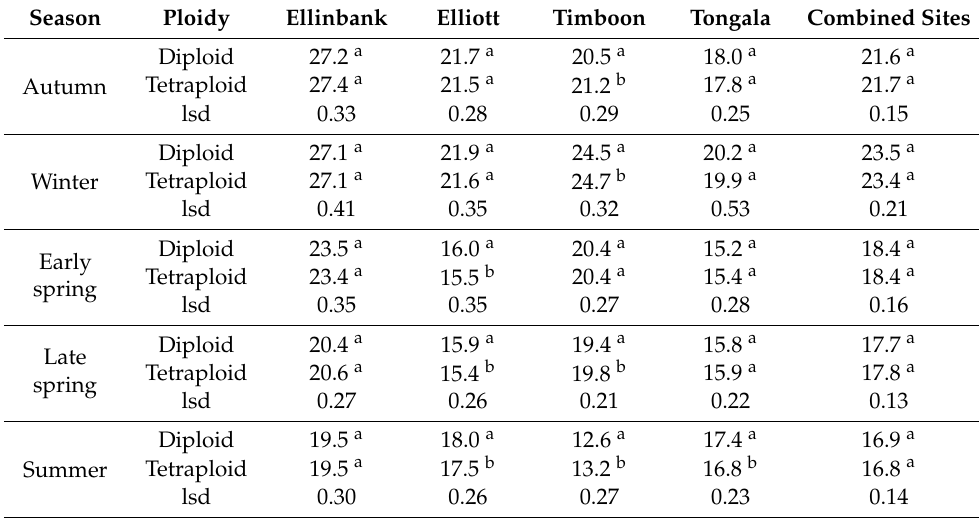
Table 4. Seasonal mean differences in crude protein (% DM) across three years between all diploid and tetraploid perennial ryegrass candidates at 4 trial sites in south-eastern